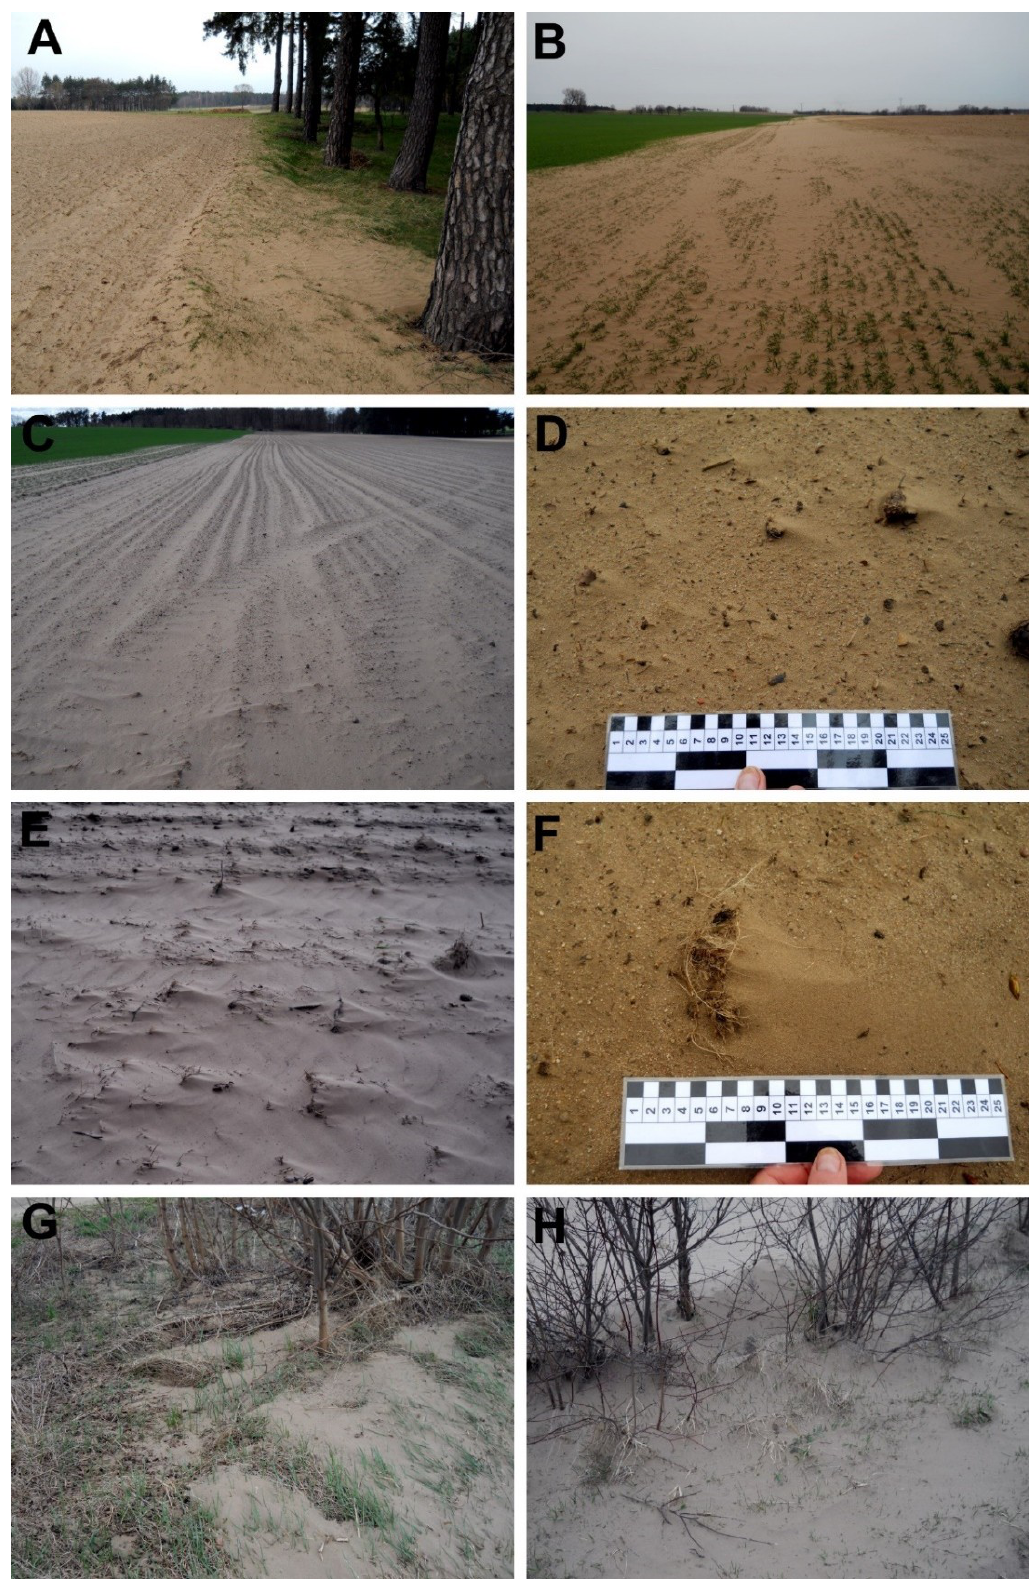
Figure 7. Aeolian accumulative forms in the research fields. ( A – C )—aeolian covers; ( D , E )—aeolian shadows; F—aeolian microshadows; G,H—accumulation near shrubs; (photos taken on 9 April, 2011). There were ripple marks on the surface of all aeolian covers (Figures 8A,B) with a stretch of up to 0.25 m. The Swoboda field had smaller ripple marks with a stretch of about 0.03–0.05 m. Their